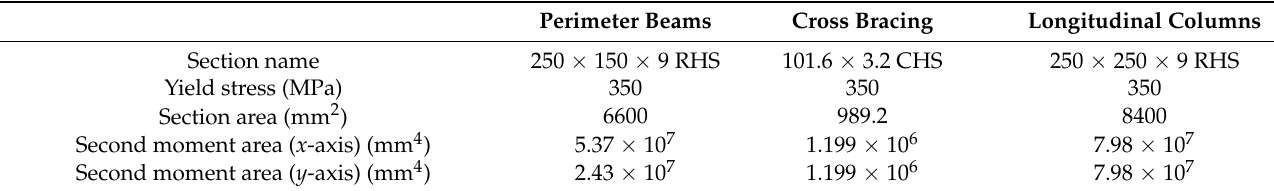
Figure 3. Schematic design of the model: ( a ) front view of the half-structure; ( b ) structural member demonstration. Table 1. Section property for different members. Table 1. Section property for different members.